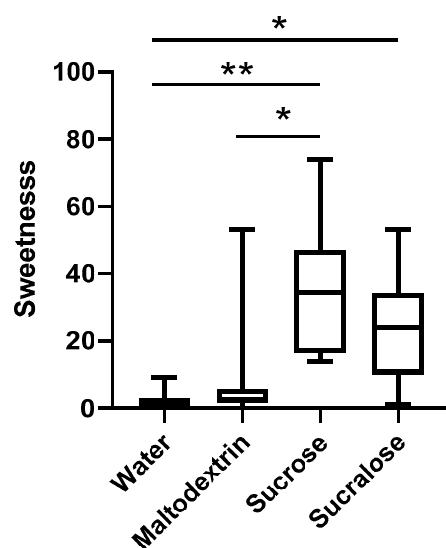
Figure 2. Sweetness intensity of water, maltodextrin, sucrose and sucralose, measured on the generalized labeled magnitude scale (gLMS). Box represents median, upper and lower quartiles, whiskers show min and max. Stars denote statistical significance, * p < 0.05; ** p < 0.01.